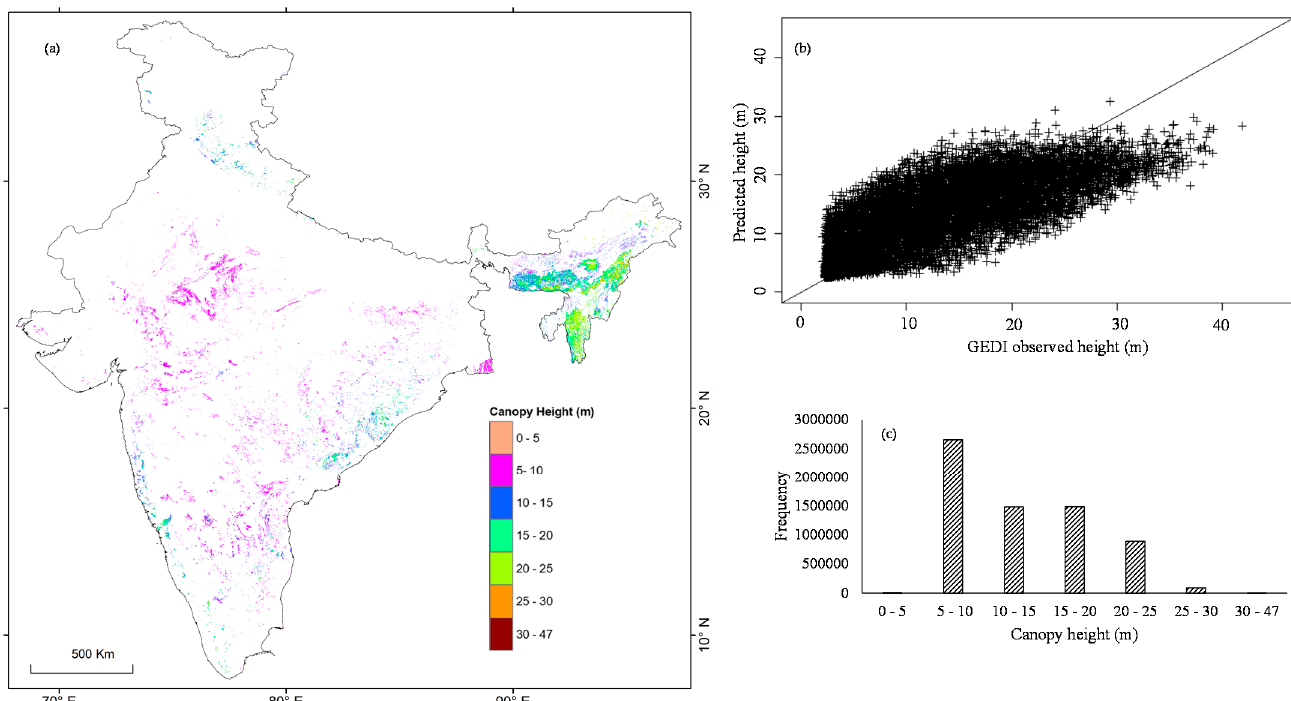
Figure 5. ( a ) GEDI predicted forest canopy height map, ( b ) the RF model predicted vs. the field- estimated height plot using the GEDI data and ( c ) histograms showing the canopy height distribution for the mixed forest.